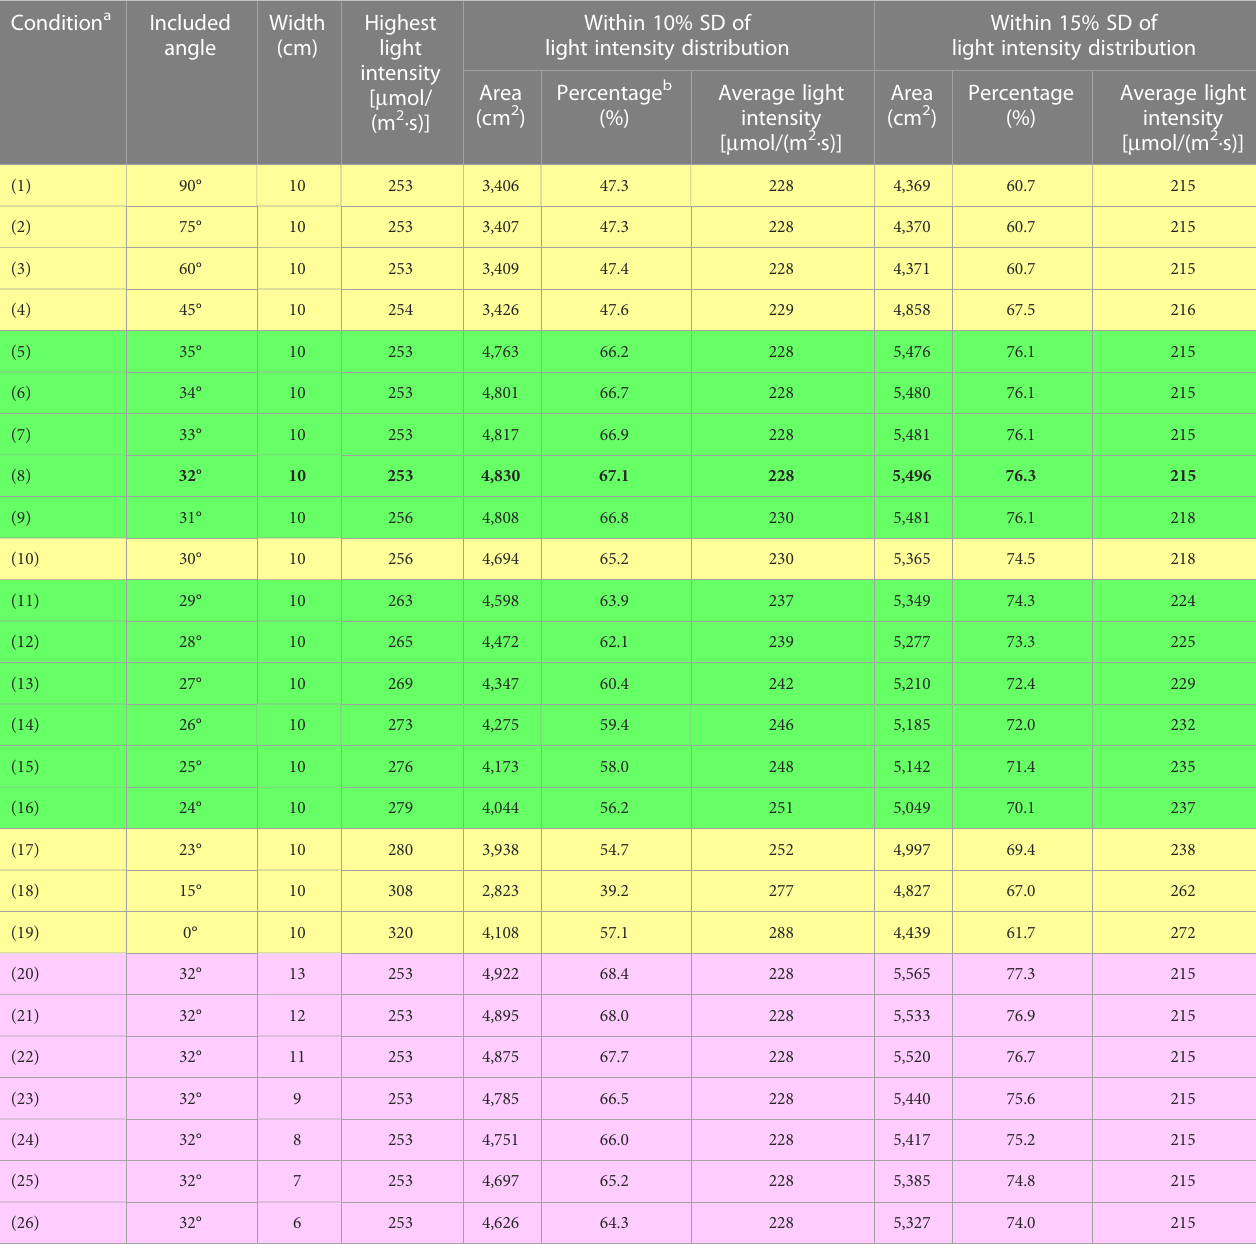
a Table background in yellow, green, and pink colors stands for the sketchy screening for the optimal range of the included angle, the fi ne screenings for the exact included angle, and the optimal combination of the included angle and the re fl ective board width,